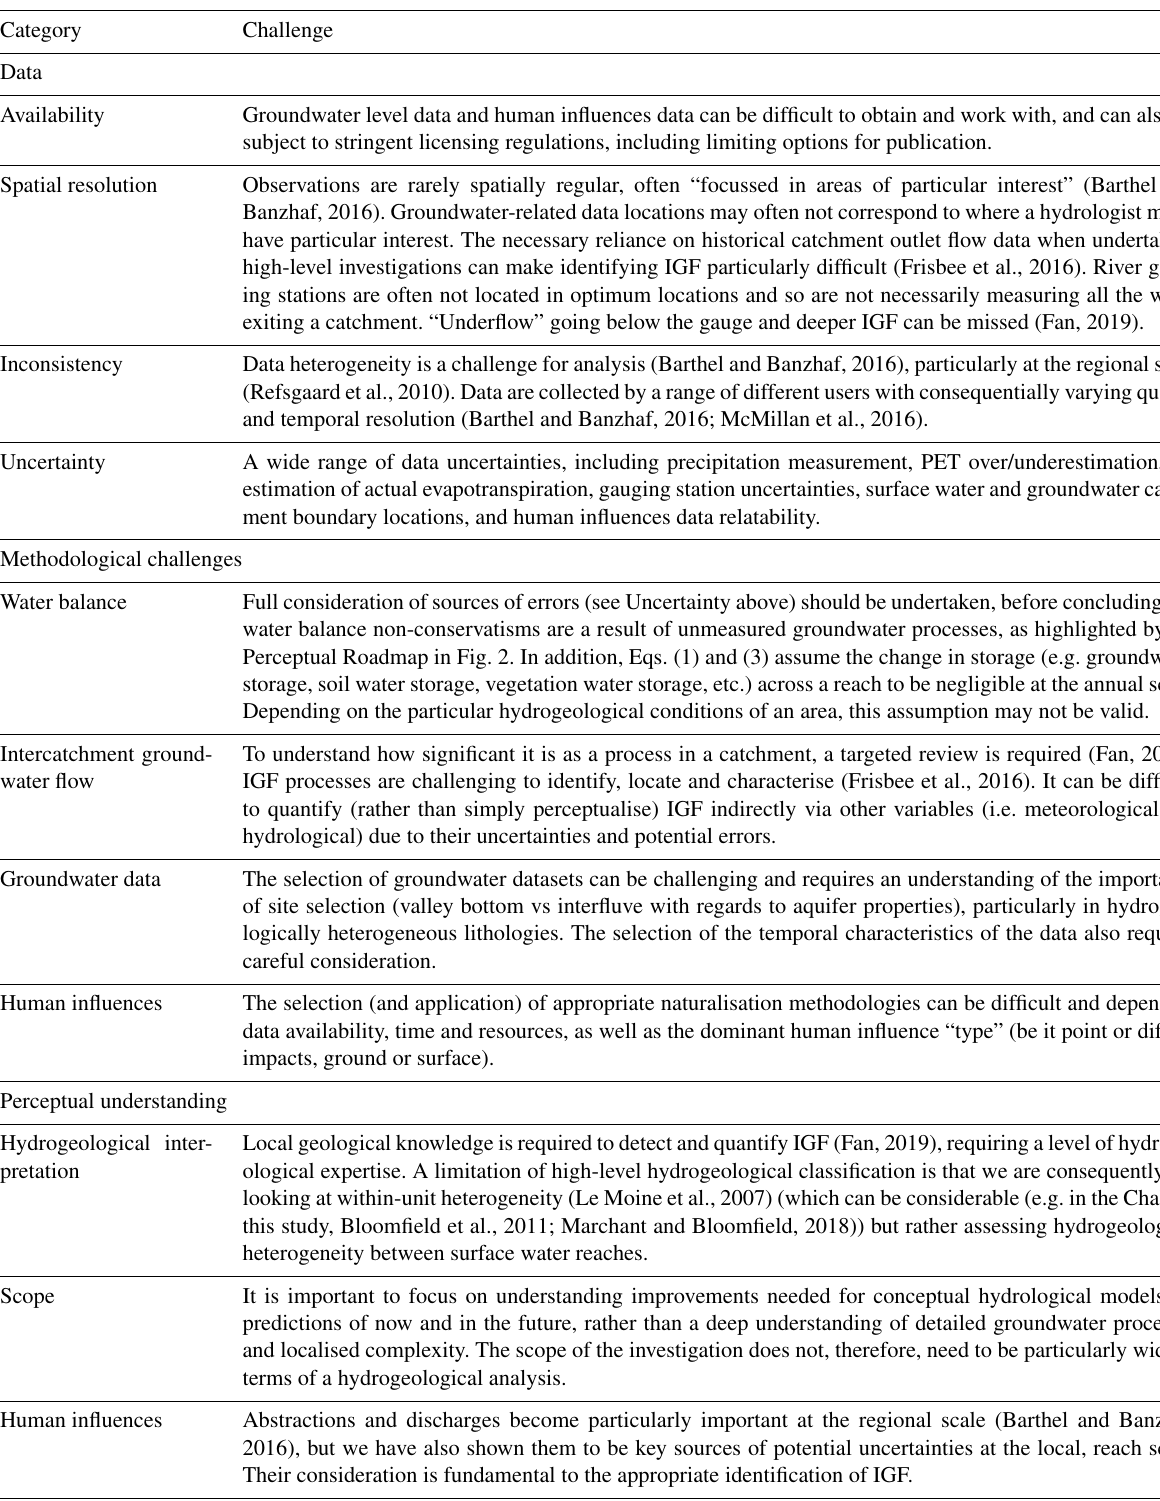
Table 3. Matrix of challenges when developing a perceptual model of the intercatchment groundwater flow environment for the purposes of improved hydrological modelling, split by challenge